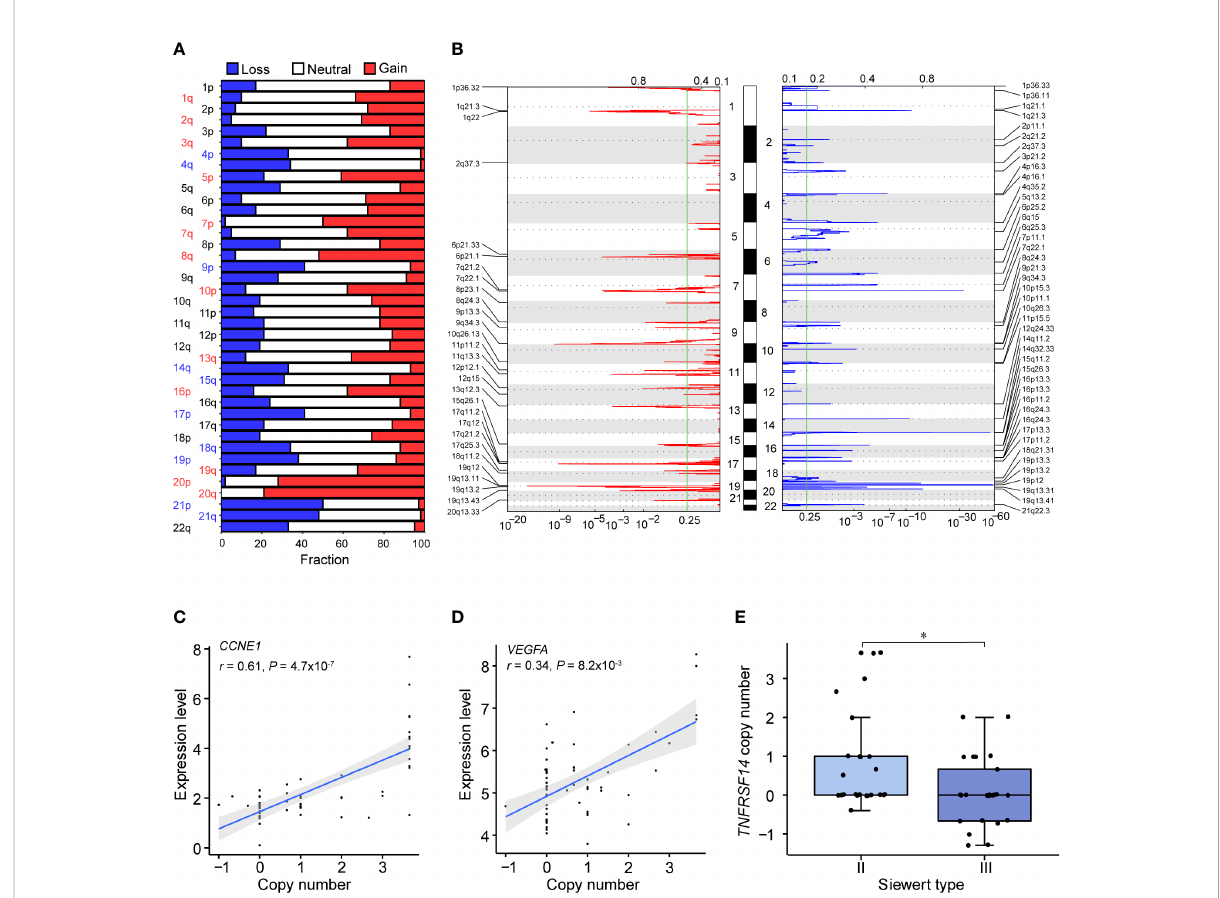
FIGURE 2 Somatic CNVs identi fi ed in our ACGEJ samples. (A) CNVs at the chromosome arm level. The bar graphs show the frequency of arm-level copy-number alterations, and the horizontal axis represents chromosome arms. Signi fi cant chromosome arm gains and losses ( q < 0.25 and frequency > 30%) are indicated in red and blue, respectively. (B) Focal peaks of ampli fi cations (left) and deletions (right) detected by GISTIC 2.0. The x axis represents the false discovery rate, and the y axis represents the chromosome. The green line represents the signi fi cance threshold ( q = 0.25). (C, D) Correlations between the copy number and expression level of two putative CNV driver genes, CCNE1 (left) and VEGFA (right). The copy number data on the horizontal axis were derived from the GISTIC output (all_data_by_genes.txt fi le). P values were derived from Spearman ’ s correlation tests. (E) Comparison of TNFRSF14 copy number between Siewert II and III samples. P values were derived from Wilcoxon rank-sum tests. Statistical signi fi cance was described as follows: *P <